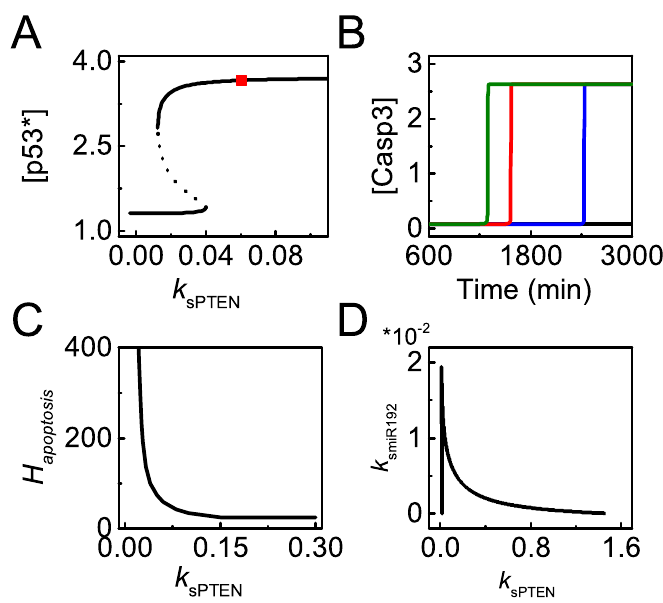
Figure 10. Effect of PTEN induction on p53 activity and cellular outcome. ( A ) bifurcation diagram of [p53 ∗ ] versus k sPTEN with DD = 100. The red square symbolizes the default case. ( B ) time courses of [Casp3] with k sPTEN = 0.2 (dark green), 0.06 (red, the default case), 0.042 (blue), and 0.03 (black) at DD = 100; ( C ) the curve of H apoptosis versus k sPTEN ; ( D ) the two-parameter bifurcation diagram of k smiR192 versus k sPTEN